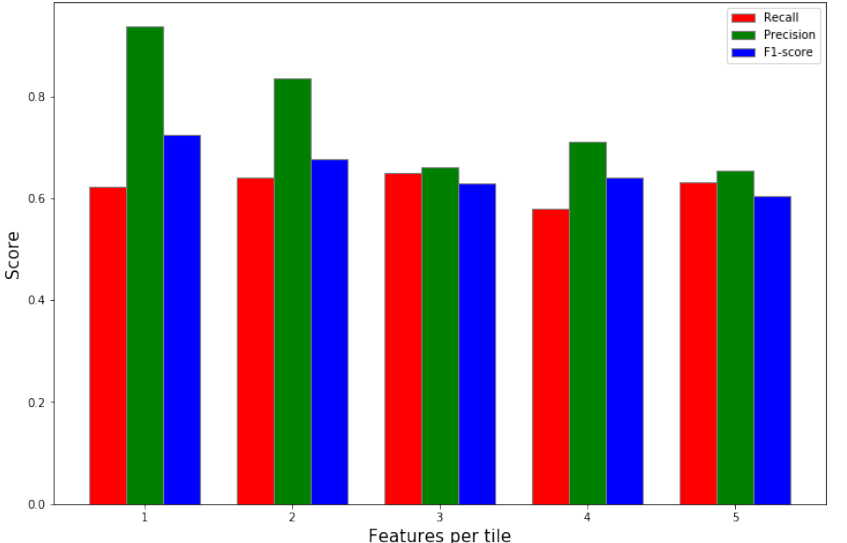
Figure 7. Comparing performance when including several feature vectors per tile calculated at different distances from reference pixel. The negligible improvement in performance demonstrates the irrelevance in the calculated features at distances larger than 3 tiles. However, we notice an increase in the performance, although trivial, when including two vectors (at d = 2, and d = 4). In Figure 8, we display some of the resultant frames from the testing stage. In the upper row, are the input images, the middle row are the results from using a larger window size (64 × 64) which results in the tiling effect in the predicted mask. Finally in the bottom row, the results from using window size of 32 ×